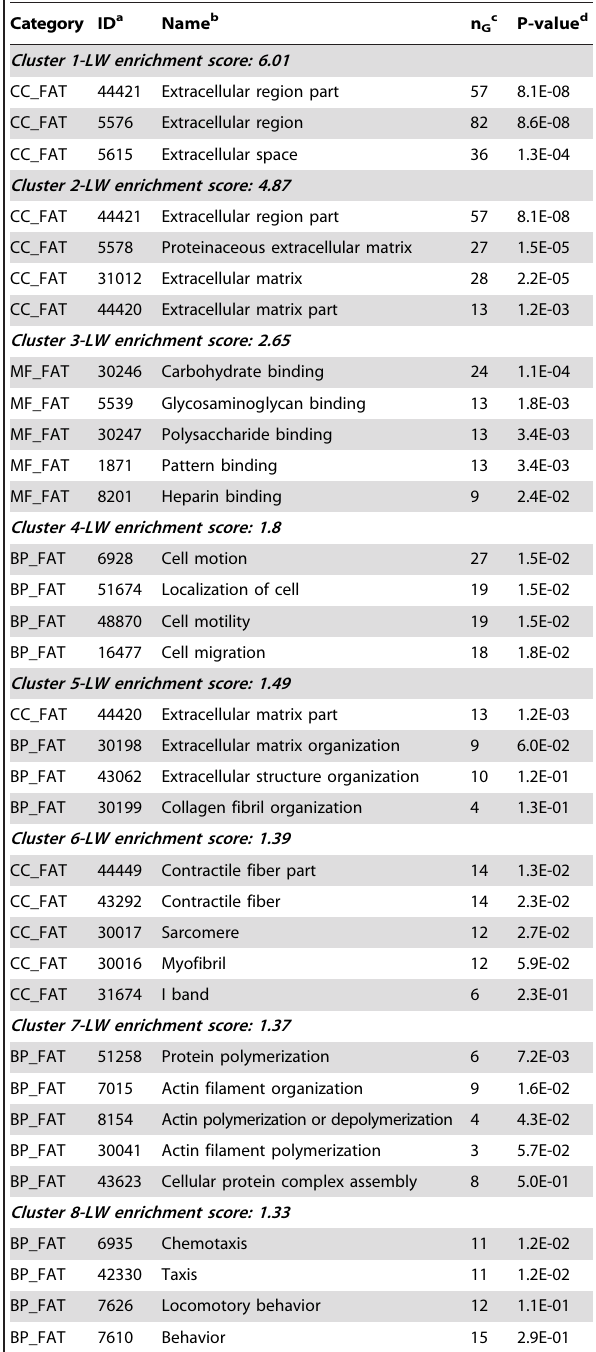
Table 6. Functional annotation clustering for genes highly expressed in the Longissimus muscle of Large White (LW, n= 20)